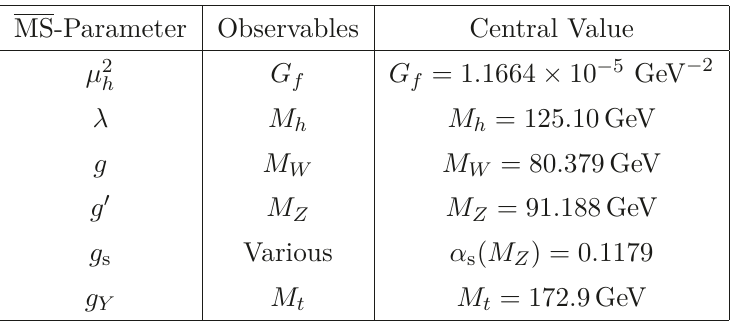
Table 1 . Experimental values for observables from ref. [100]. Observables and MS-parameters are matched at one-loop order, at the input scale ¯ µ = M Z with details of the matching relations collected in appendix A.1. Multiple observables are involved in calculating a global average of the strong coupling constant g s